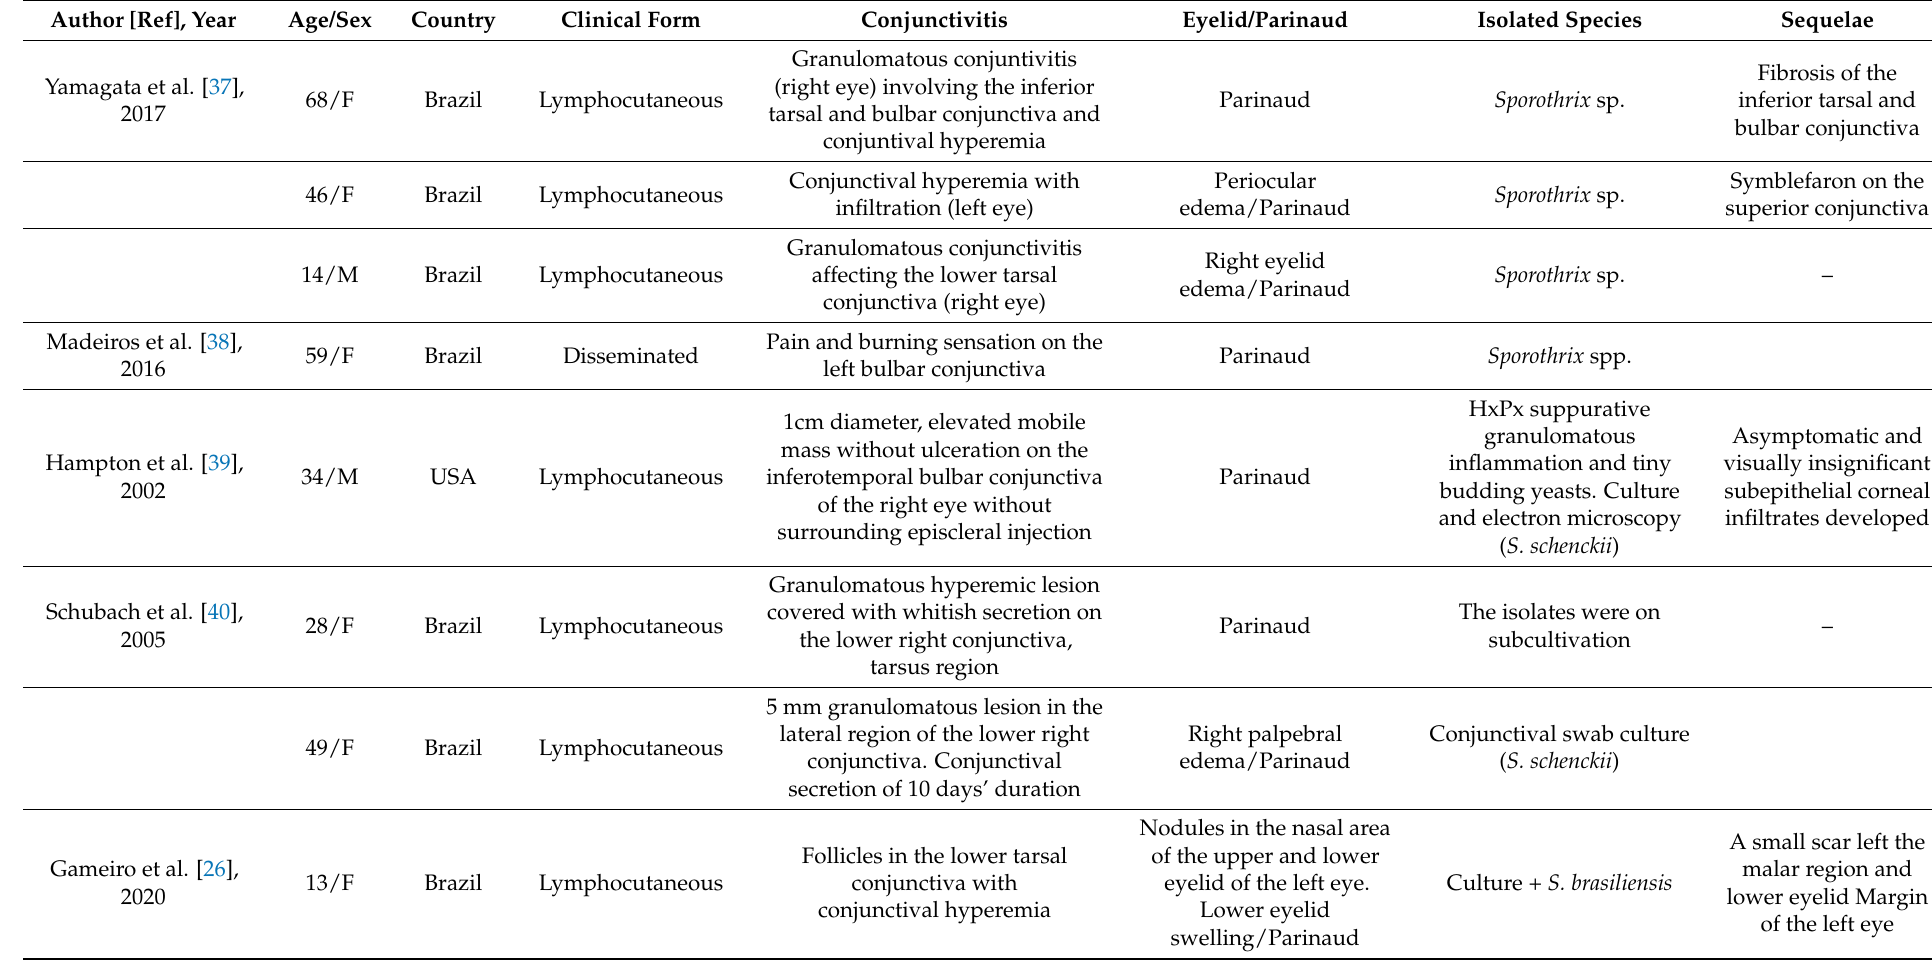
Table 3. Most common findings of conjunctival sporotrichosis in cases report and case